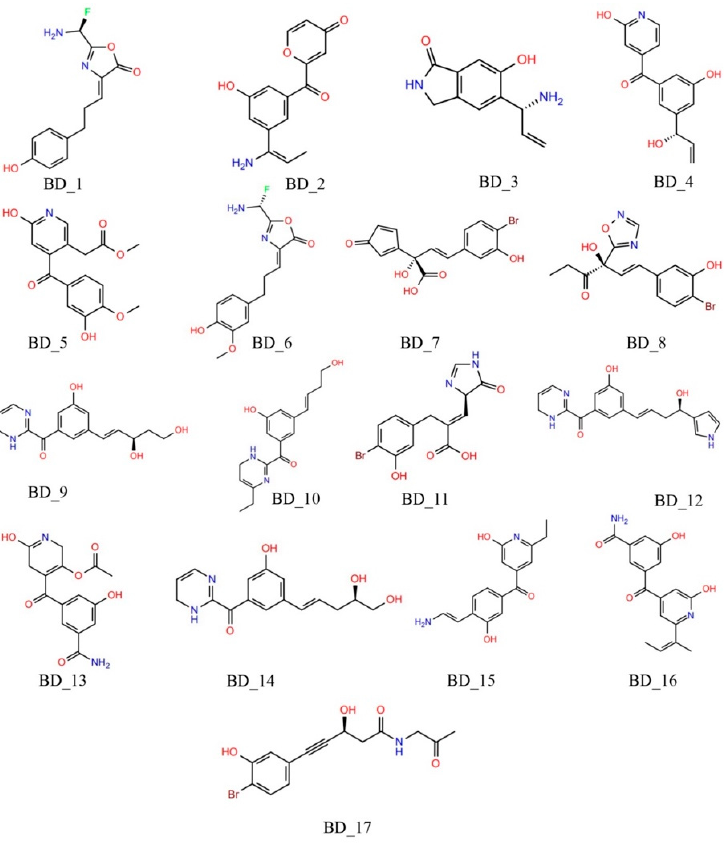
Figure 3. Two-dimensional representation of the final 17 de novo designed molecules for